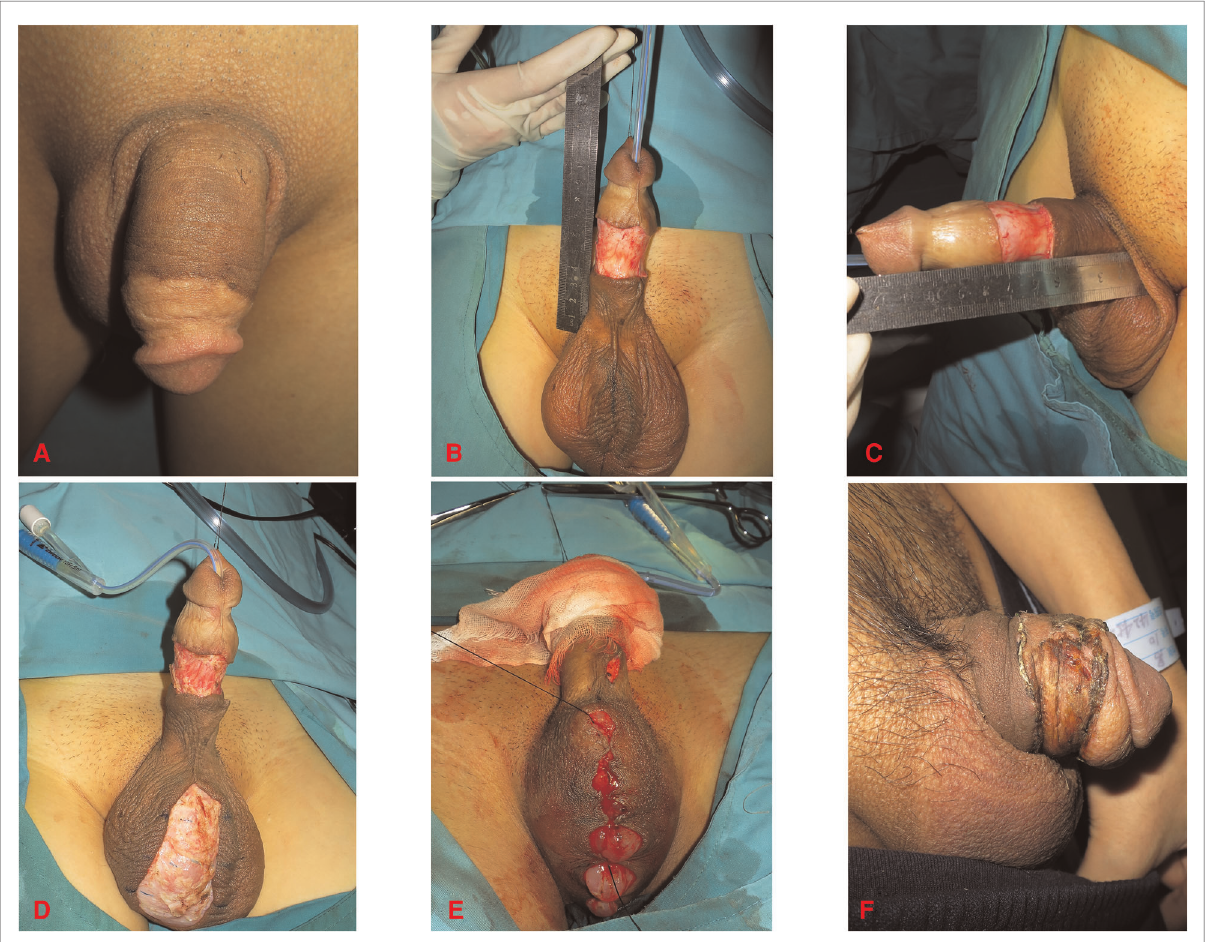
FIGURE 1 42-year-old male. ( A ) Preoperative photograph of the penis. ( B,C ) Incision of the penile skin. ( D ) Scrotal wound after skin removal. ( E ) Closure of the scrotal incision. ( F ) Morphology of the penis three weeks after